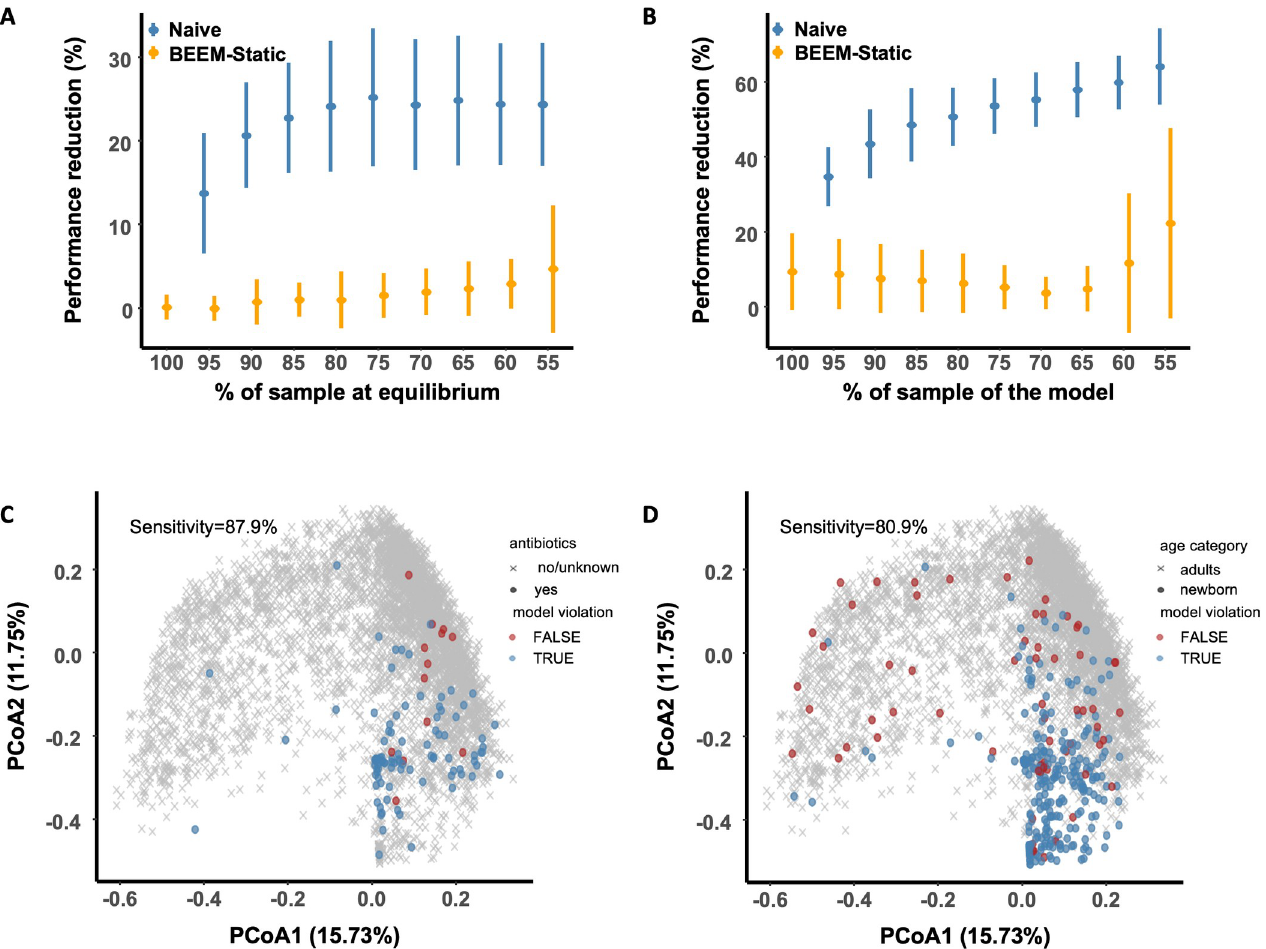
Fig 3. BEEM-Static robustly filters samples violating modeling assumption in simulated and real datasets. (A-B) Performance reduction for BEEM-Static (with filters) and the na ï ve algorithm (without filtering of samples) as the percentage of samples at (A) equilibrium or (B) generated from the main model, decreases. Reduction is measured relative to BEEM-Static with no filters and all data from the model and at equilibrium. Points denote the means while error bars denote the standard deviation across 30 simulations each. (C-D) Principal coordinates plots (Bray-Curtis dissimilarity) representing gut microbiome taxonomic profiles from 4,617 samples. Points represent samples from individuals taking antibiotics (C) or from newborn infants (D), while crosses represent samples from adults who are not undergoing antibiotic treatment. Points that were filtered by BEEM-Static are colored blue and red otherwise.